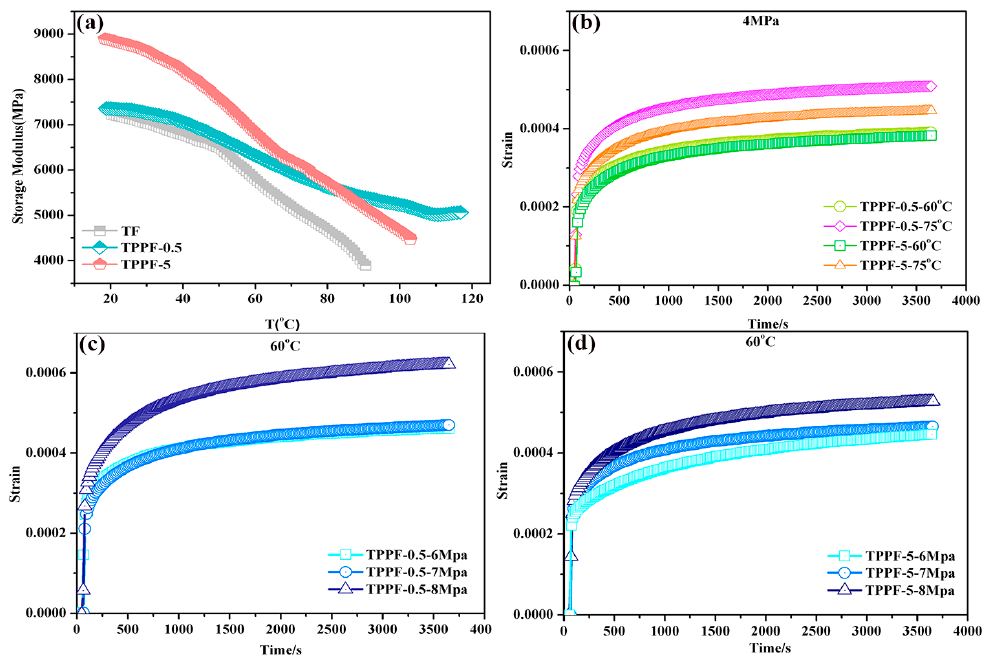
Figure 9. ( a ) Storage modulus, and ( b – d ) the creep response under different conditions for TPPF-0.5 and TPPF-5.